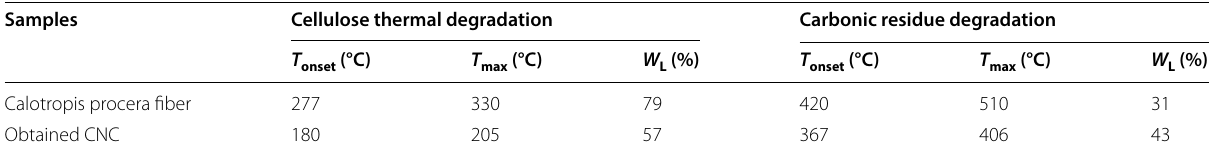
Table 2 Onset temperature ( T for CPF and the obtained